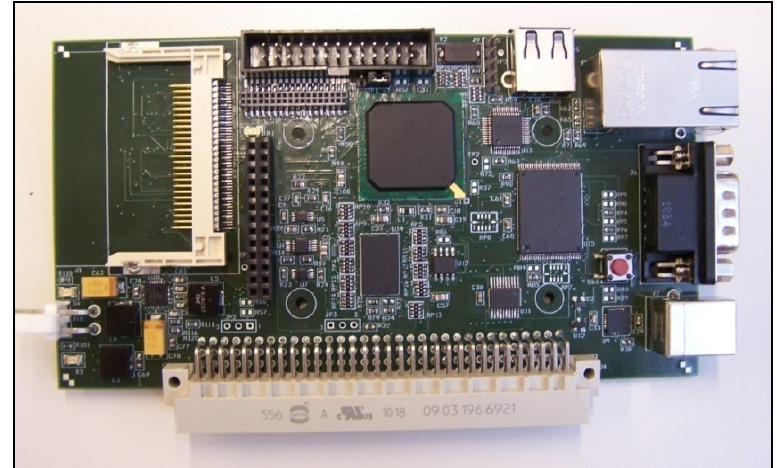
Figure 18. MCF54455 processor